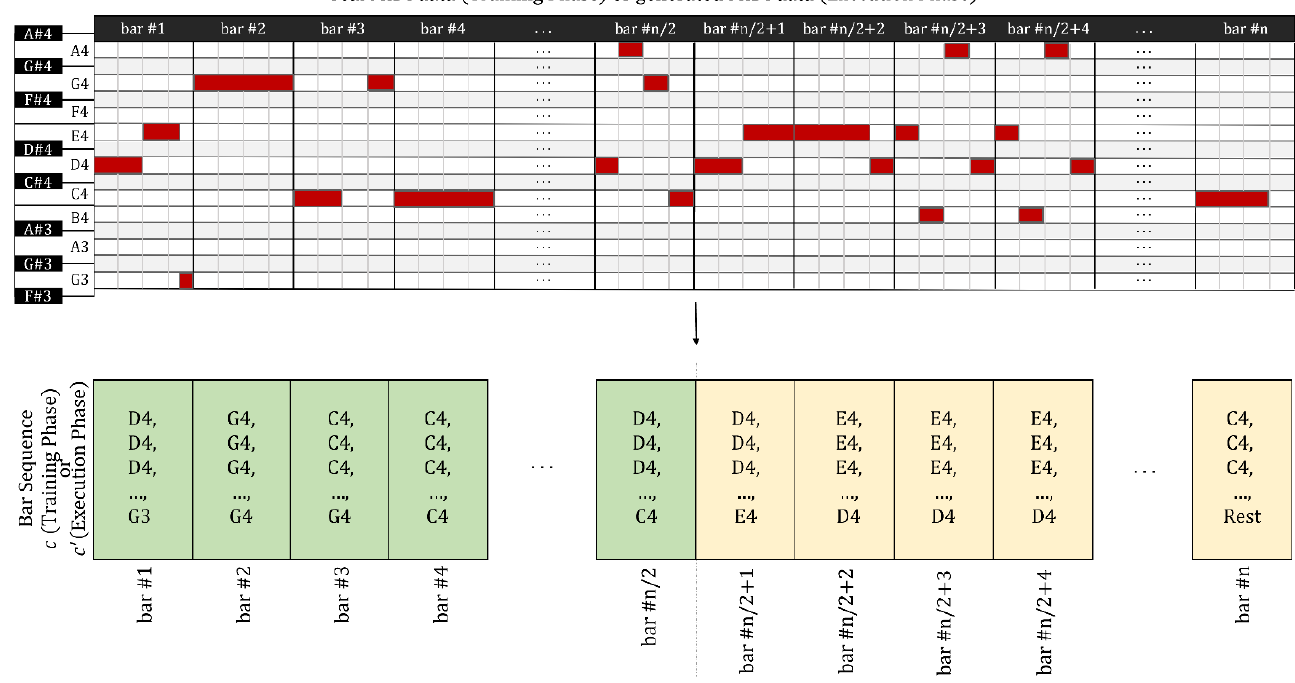
Figure 4. Conversion process of the note converter.